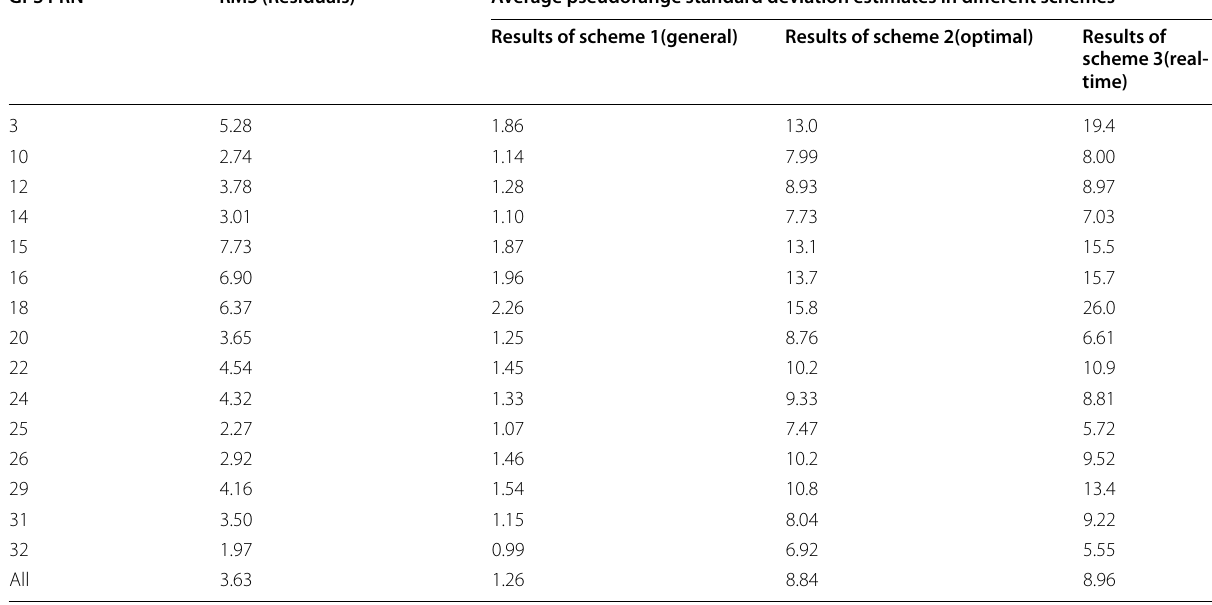
Table 4 Statistical results of the RMS of pseudorange measurement residuals and average pseudorange standard deviation estimates for each satellite GPS